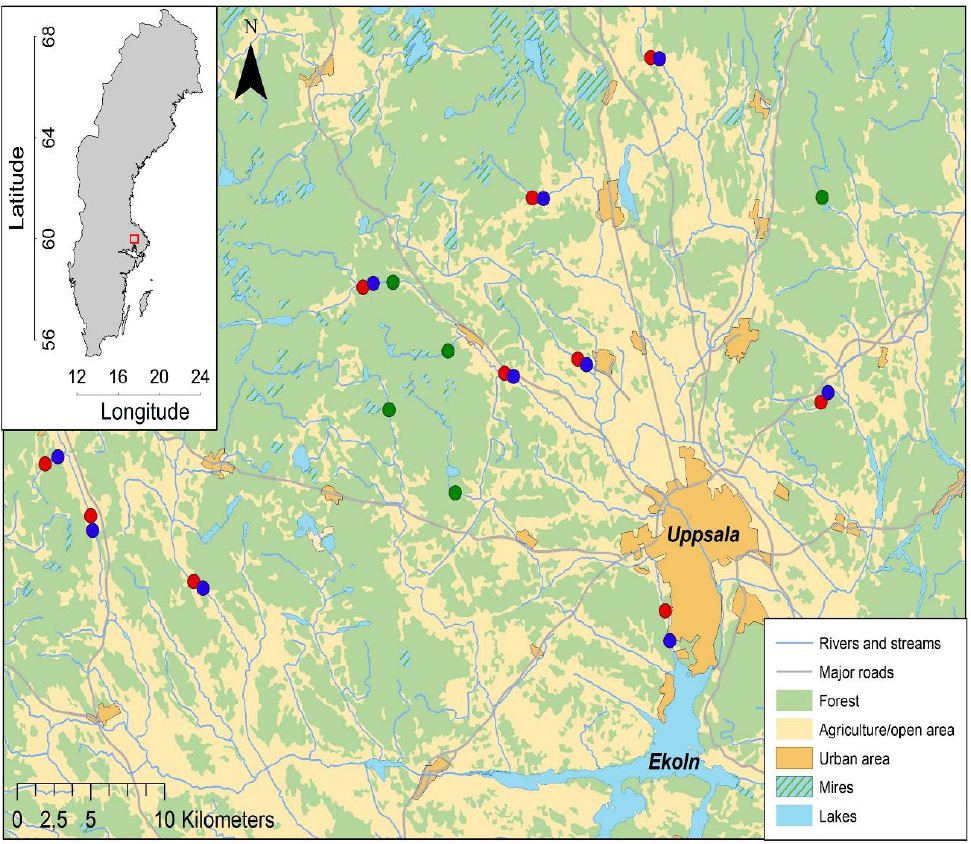
Figure 1. Map of the Ekoln basin with forest sites (green) and paired agricultural sites: (red) unbuffered sites and (blue) buffered sites. Insert map: the red box indicates the study region location in Sweden.